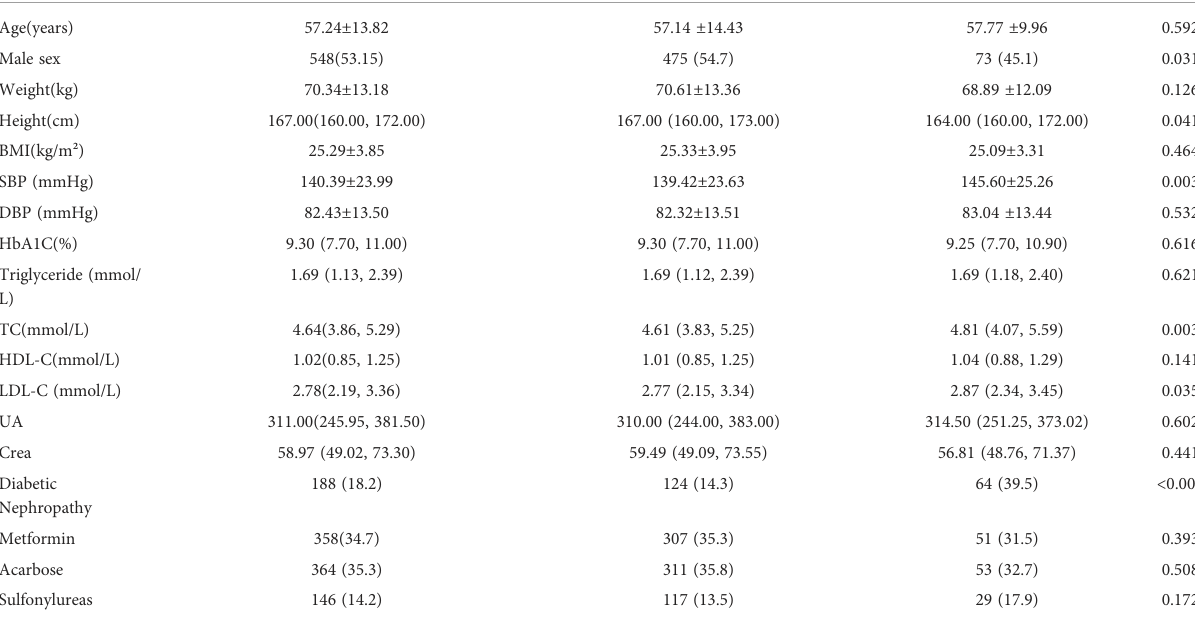
TABLE 1 Clinical and biochemical characteristics of participants according to the occurrence of diabetic retinopathy.